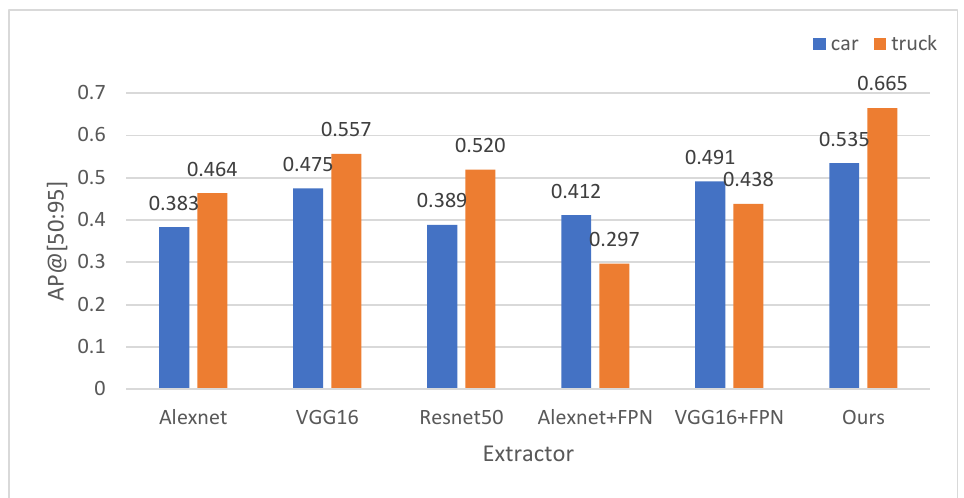
Figure 17. The comparison results of the proposed detection method with Faster-RCNN using other extractors on AP@[50:95].